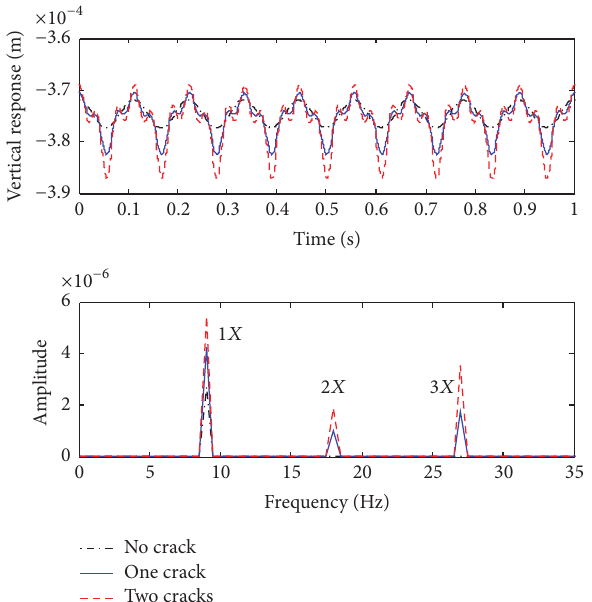
Figure 3: Steady-state responses comparison of rotors without any crack, with one crack and with two cracks (the one crack located in the 12th element with depth of 0.2 and the two cracks located in the 11th and 17th elements both with depth of